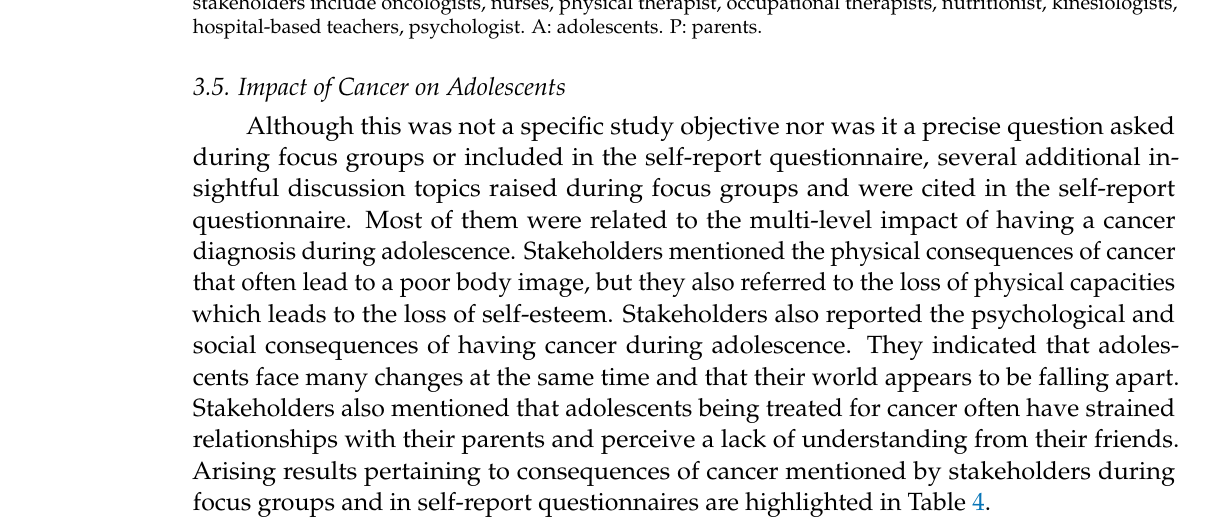
Table 4. Stakeholders’ perception of the impact of cancer on